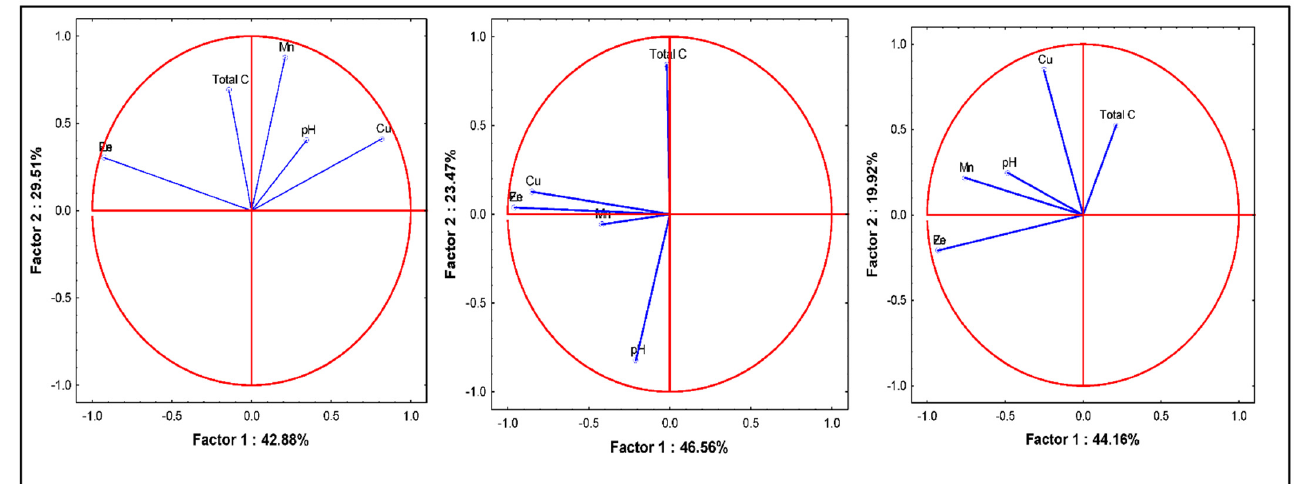
Figure 11. The principal component analysis showing distribution and the relationship between measured variables (extractable Zn, Cu, Mn, Fe, total C and pH) and tillage practices (CT, RT and NT). Zn = Zinc, Cu = Copper, Mn = Manganese, Fe = Iron, Total C = total soil organic carbon, pH = Soil pH, CT = conventional tillage, RT = rotational tillage, NT = no-till.